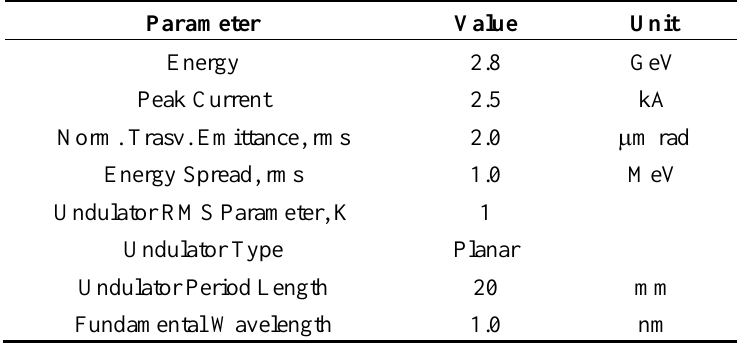
Figure 4. Minimum 3-D power gain length ( left ) and optimum betatron function ( right ) as function of the slice normalized transverse emittance at the undulator, for the M. Xie (circles) and E. Saldin et al. (dots) formulas. Table 1 . List of parameters for SASE FEL used to compare M. Xie [53] and E. Saldin et al. [54] 3-D power gain